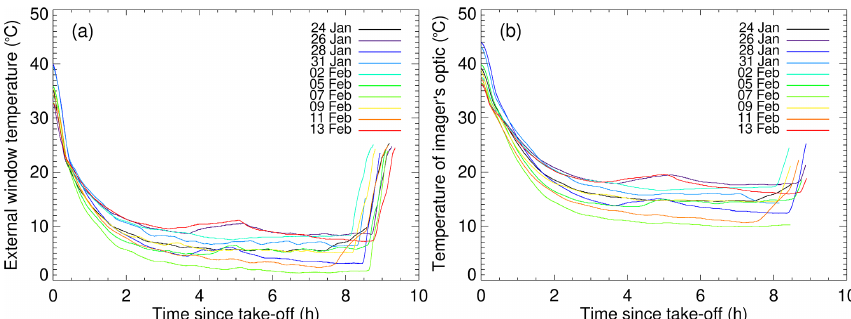
Figure 4. Time series of (a) the window temperature and (b) the temperature of the imager optics acquired during different EUREC 4 A research flights.